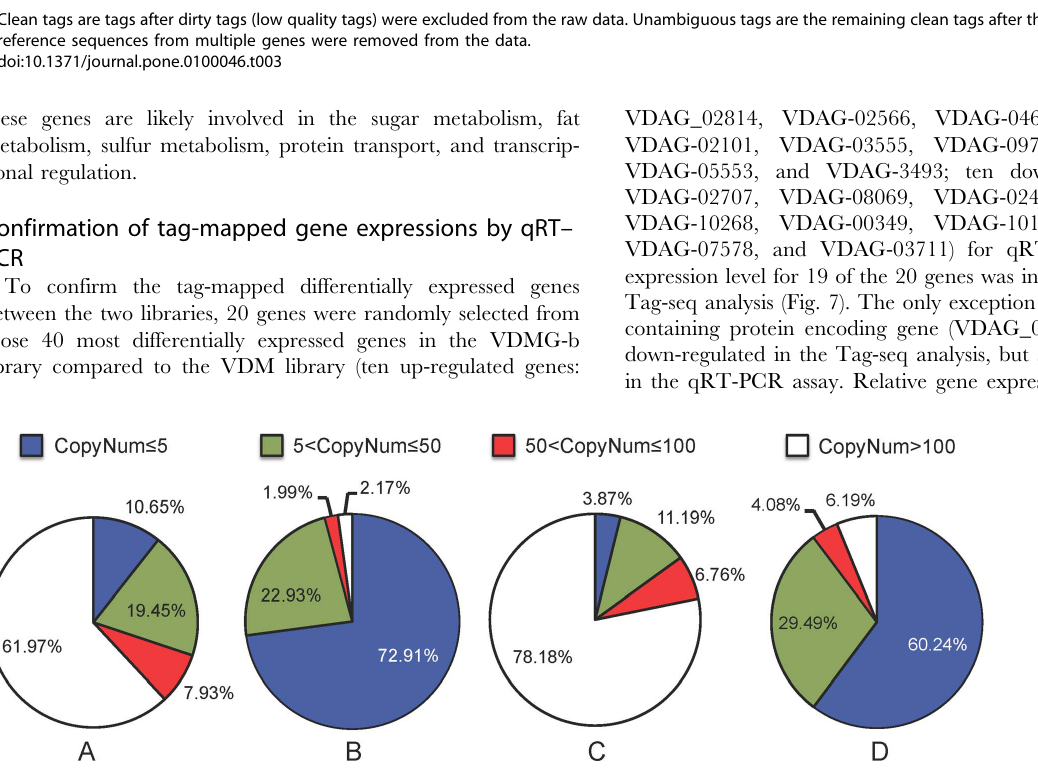
Figure 3. Frequency distribution of total tag and distinct tag counts over different tag abundance categories from the two libraries of non-germinated (VDM) and germinated (VDMG-b) Verticilliumdahliae microsclerotia. A, distribution of total clean tags in the non- germinated microsclerotia (VDM); B, distribution of VDM distinct clean tags; C, distribution of total clean tags in the germinated microsclerotia (VDMG-b); D, distribution of VDMG-b distinct clean